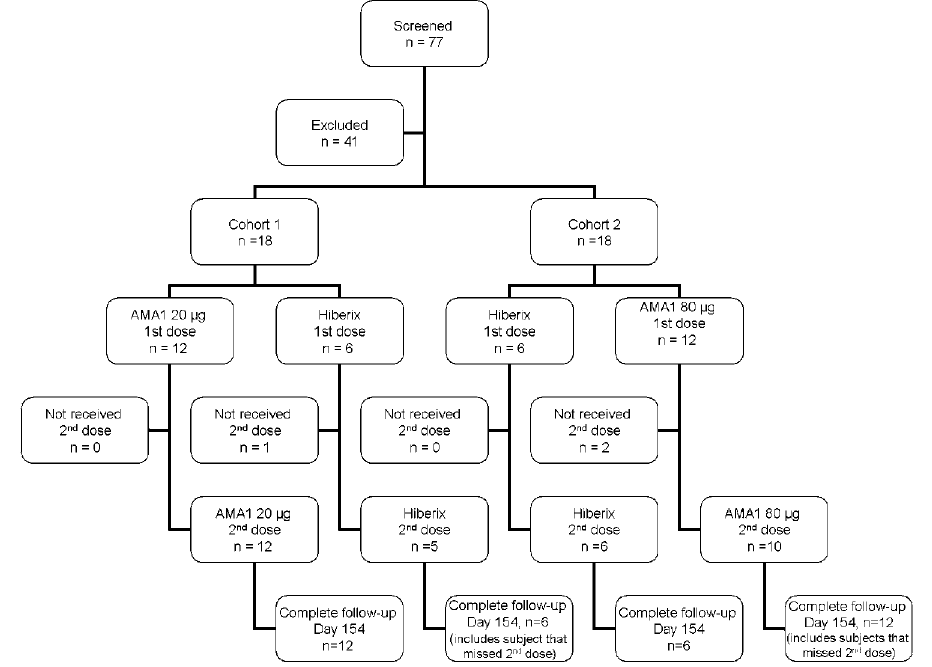
Figure 1. CONSORT Flow Chart.